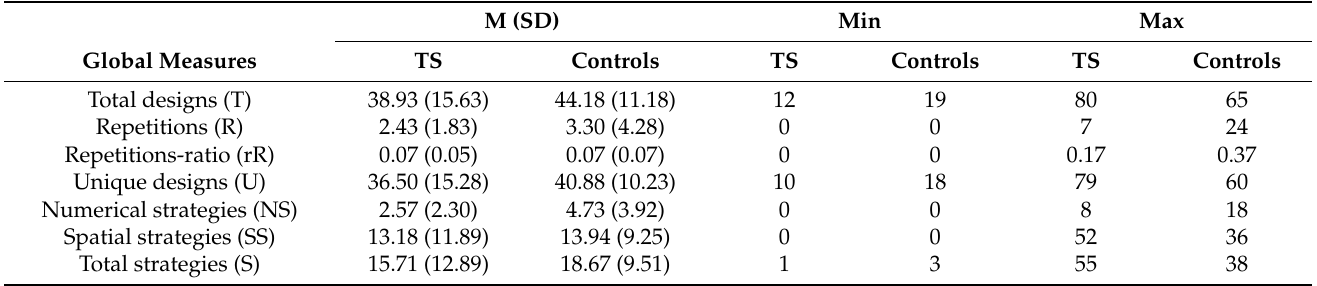
Table 3. Mean Performance of TS and Control Groups for each Global Measures on the